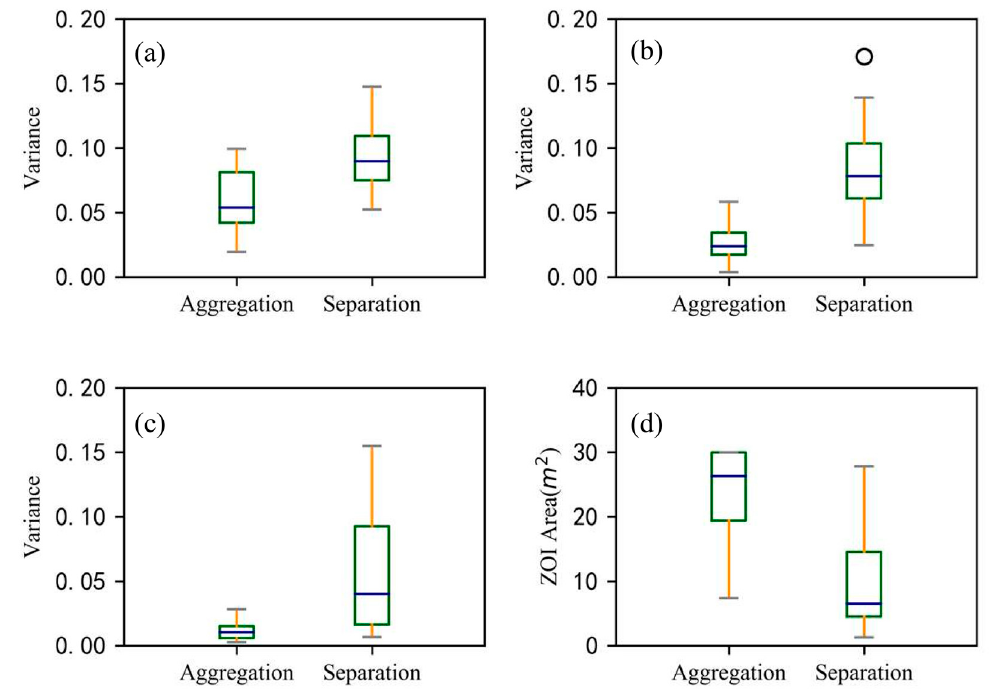
Figure 11. The degree of asymmetry of aggregated and separated ZOIs is indicated by the variances of three parameters: ( a ) the relative number of root points, ( b ) the relative maximum extension of a root, and ( c ) the relative maximum depth of roots. The three parameters of each ZOI were normalized. In addition, ( d ) the projected area of aggregated and separated ZOIs is shown. The line in the middle of the box represents the median value, and the upper and lower limits of the box are the upper quartile and the lower quartile, respectively. The whiskers represent the maximum and minimum values, except for outliers (circles).